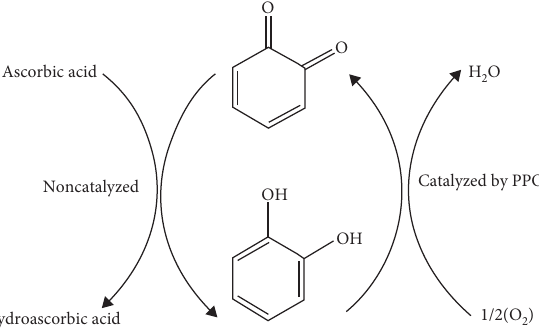
Figure 3: Reduction of o-quinones to o-diphenol by ascorbic acid [1]. Table 3: Inhibitory activity of ginger on PPO activity of the Annona muricata